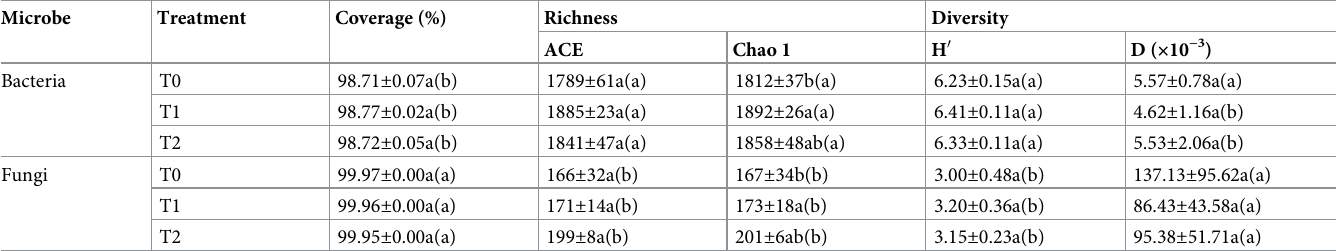
Table 4. Microbial alpha diversity as affected by fertilization and irrigation in 2018.